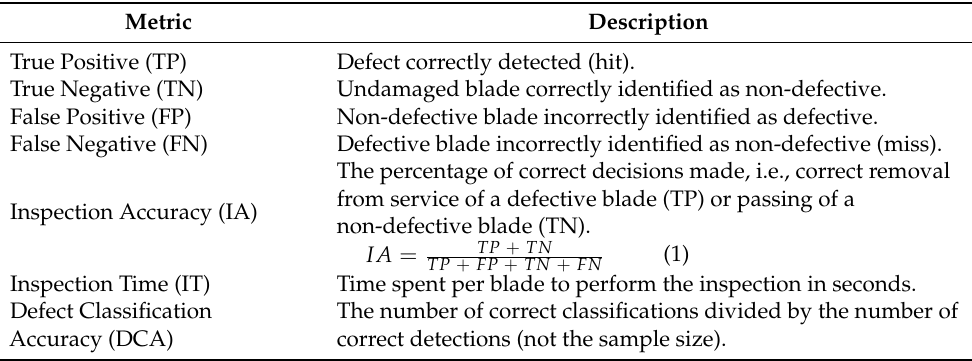
Table 2. Metrics used for measuring inspection performance.